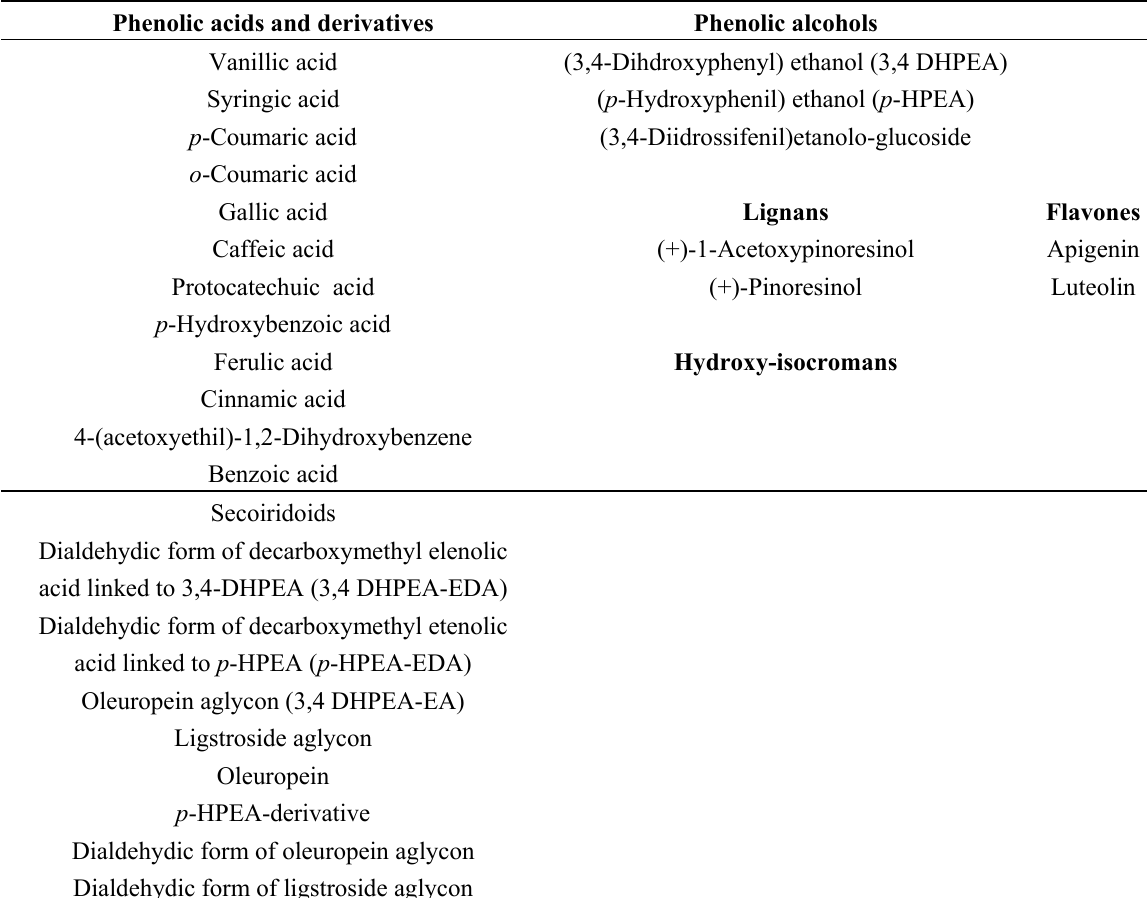
Table 1. Phenolic compounds in Extra Virgin Olive Oil